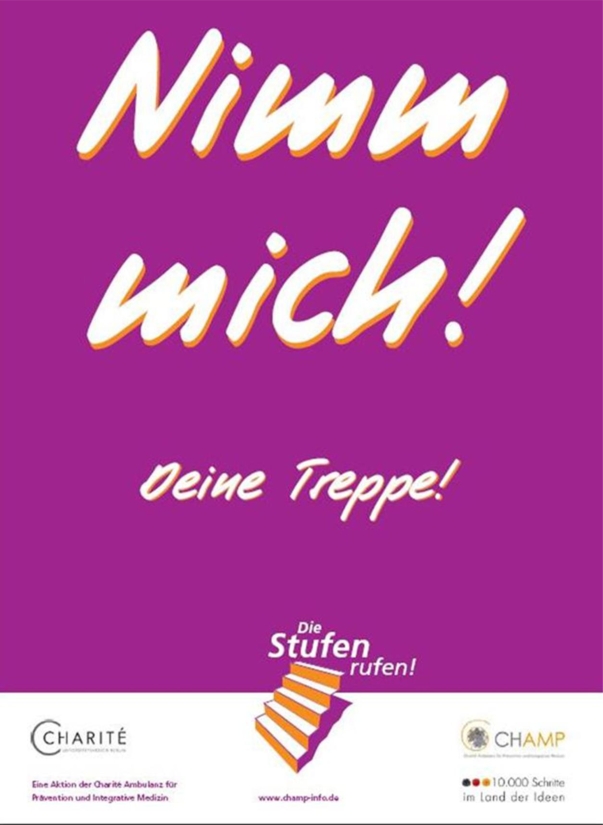
Poster design (translation of poster title “Take Me! Your Stairs!”).